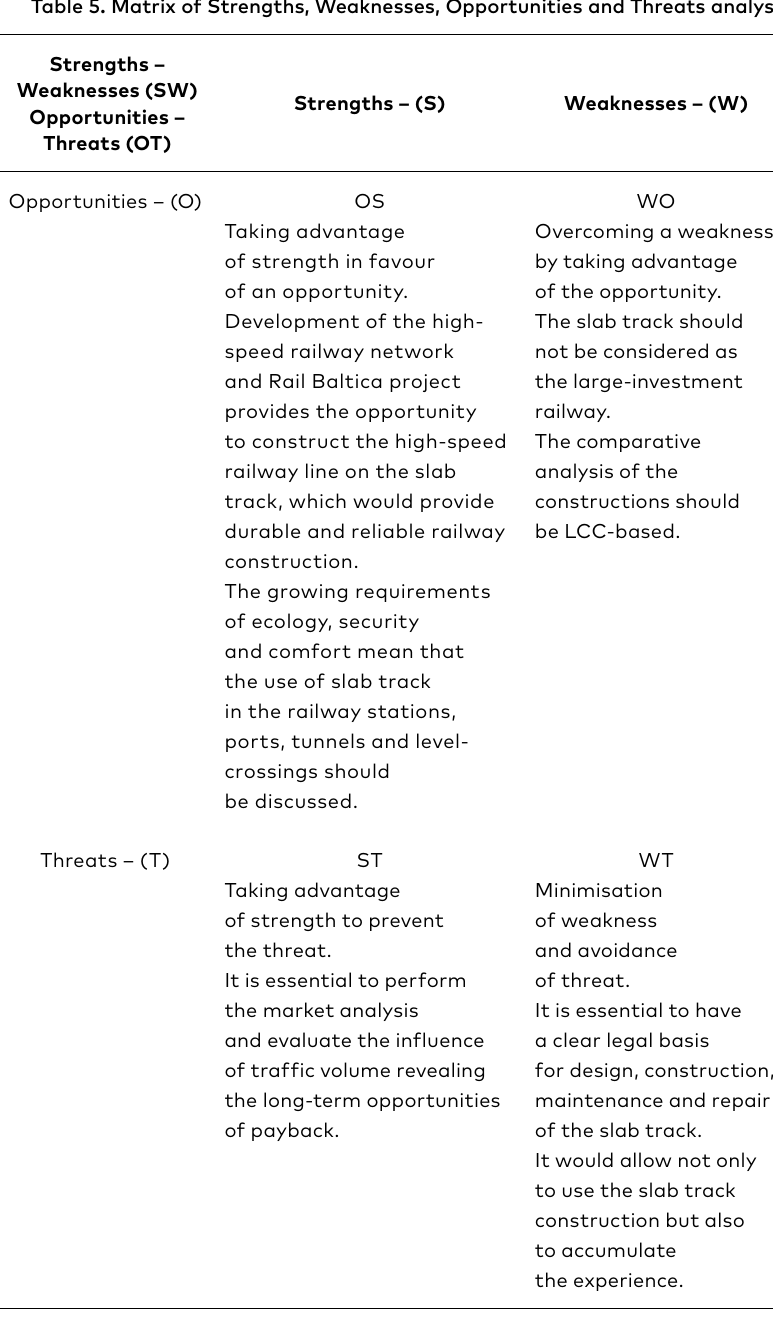
Table 5. Matrix of Strengths, Weaknesses, Opportunities and Threats